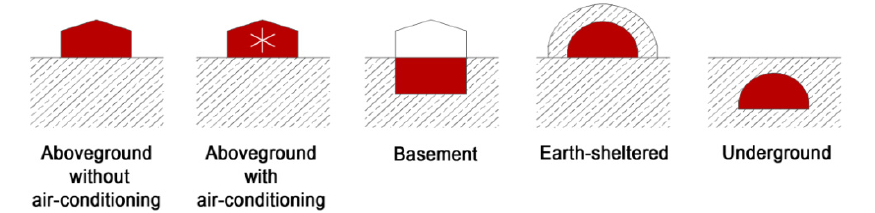
Figure 1. Diagram of building-solution options.